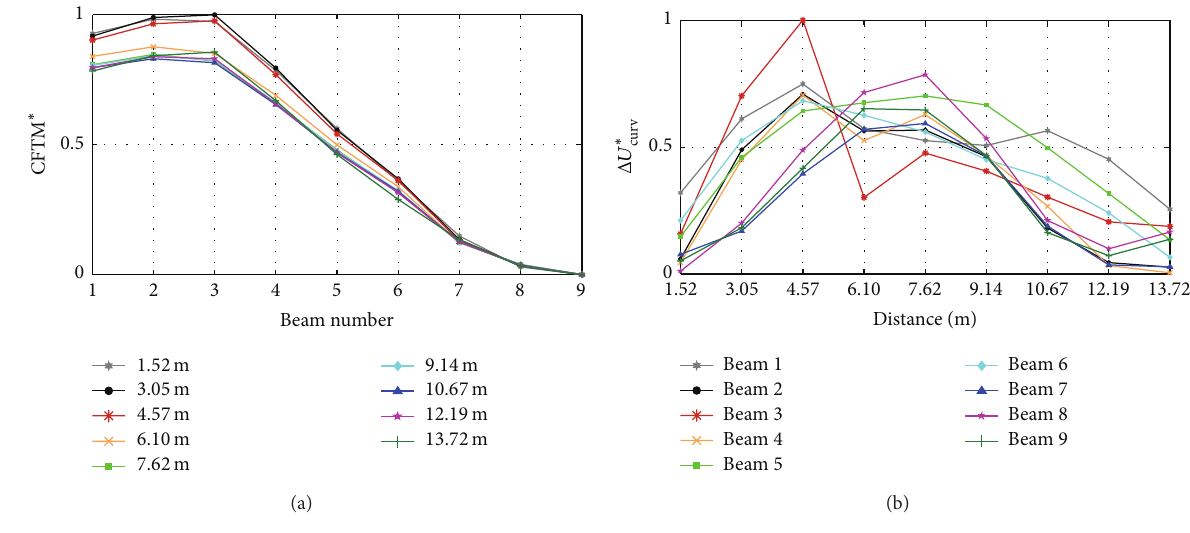
Figure 14: Plot of (a) CFTM ∗ and (b) Δ𝑈 ∗